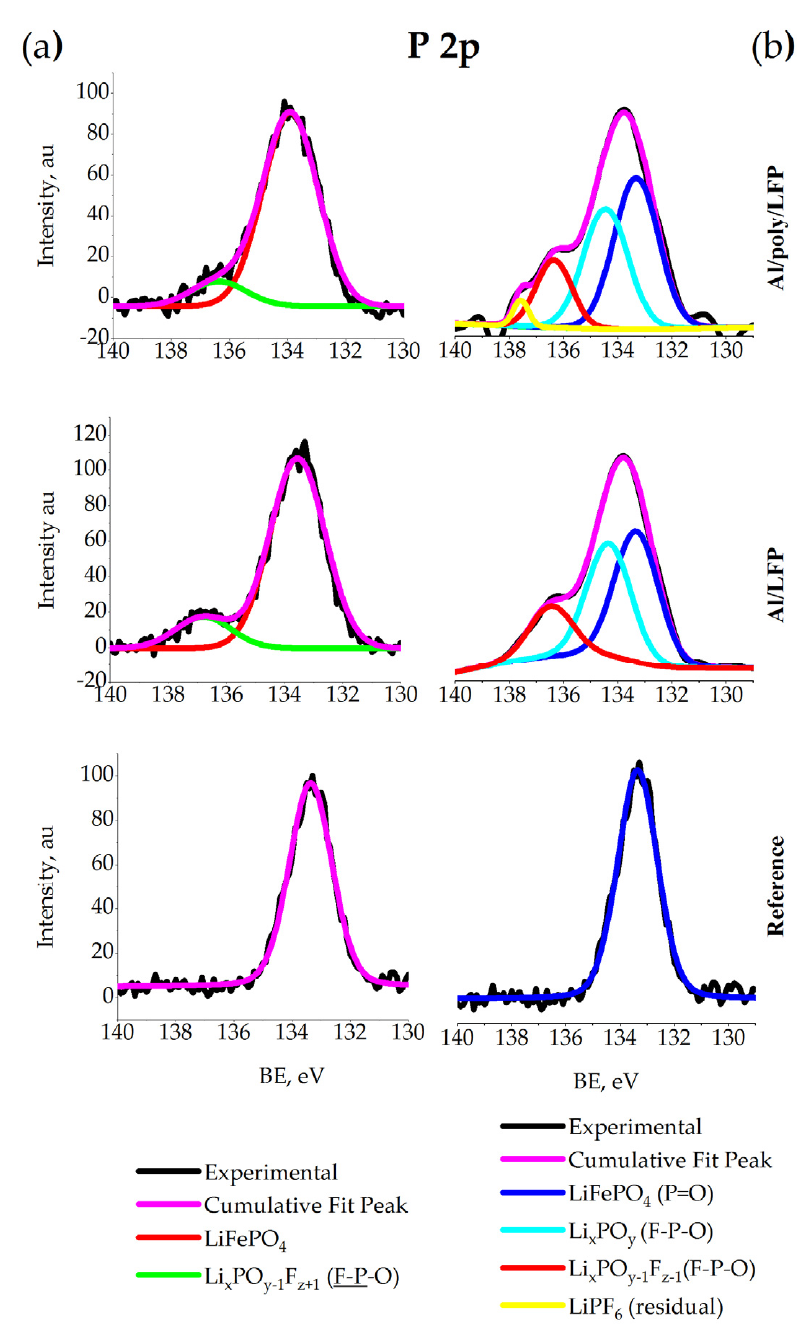
Figure 11. XPS spectra of P 2p for coin ( a ) and pouch ( b ) cells.